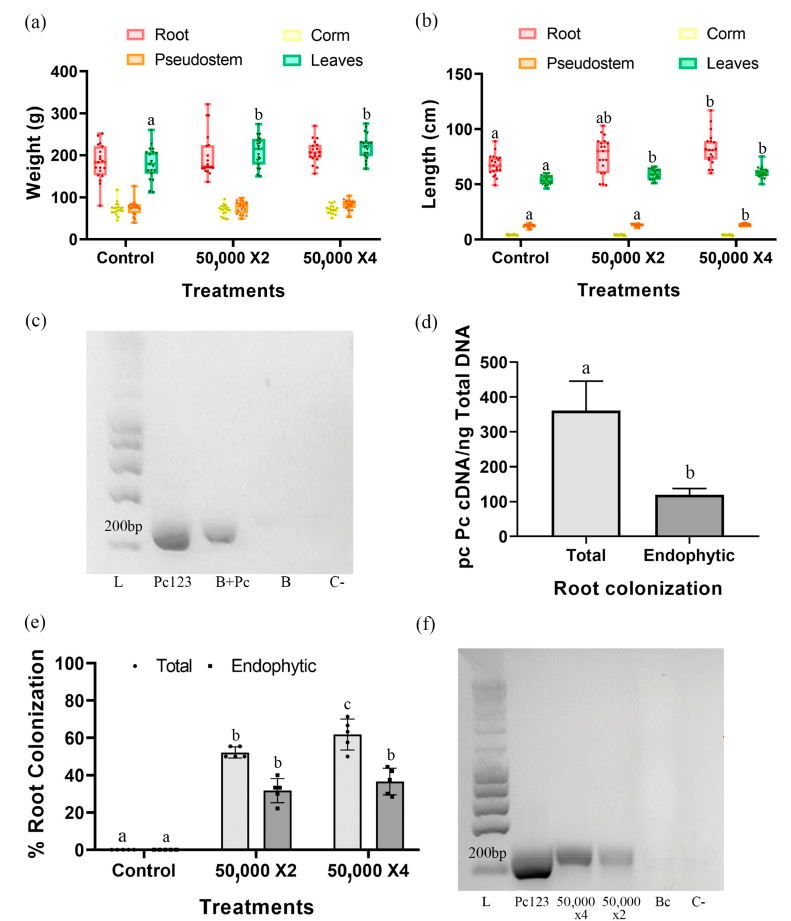
Figure 2. E ff ect of P. chlamydosporia 123 on the growth of banana plants. Treatments: 50,000 × 2, two spore inoculation; 50,000 × 4, four spore inoculation; control, uninoculated plants. ( a ) Maximum root, corm, pseudostem, and leaf weight. ( b ) Fresh root, corm, pseudostem, and leaf length. In the parameters analyzed individually, treatments with di ff erent letters indicate significant di ff erences ( p -value < α = 0.05), treatments without letters indicate there are no significant di ff erences. ( c ) Molecular detection of M. acuminata root colonization by Pc123, in 30-day-old plants. ( d ) Quantification by qPCR of Pc123 colonization of banana plant roots in 30-day-old plants. ( e ) Total and endophytic colonization of M. acuminata root colonization by Pc123 in 105-day-old plants. ( f ) Molecular detection of M. acuminata root colonization by Pc123 in 105-day-old plants. PCR of the P. chlamydosporia vpc1 gene. Abbreviations: M, ladder; Pc, DNA extracted from the mycelium of P. chlamydosporia ; B + Pc, DNA extracted from 30-day-old roots of the plant inoculated by Pc123; B, DNA extracted from the root of a 30-day-old uninoculated banana plant; 50,000 × 4 DNA extracted from four spore inoculation 105-day-old plants; 50,000 × 2 DNA extracted from two spore inoculation 105-day-old plants; Bc, DNA extracted from the root of a 105-day-old banana control plant without Pc inoculation; C-, negative control without